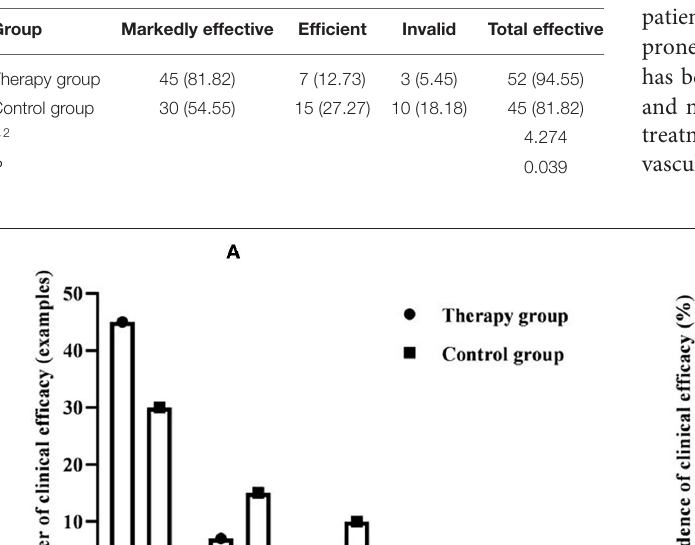
TABLE 1 | Comparison of clinical efficacy between the two groups ( n = 55, %).